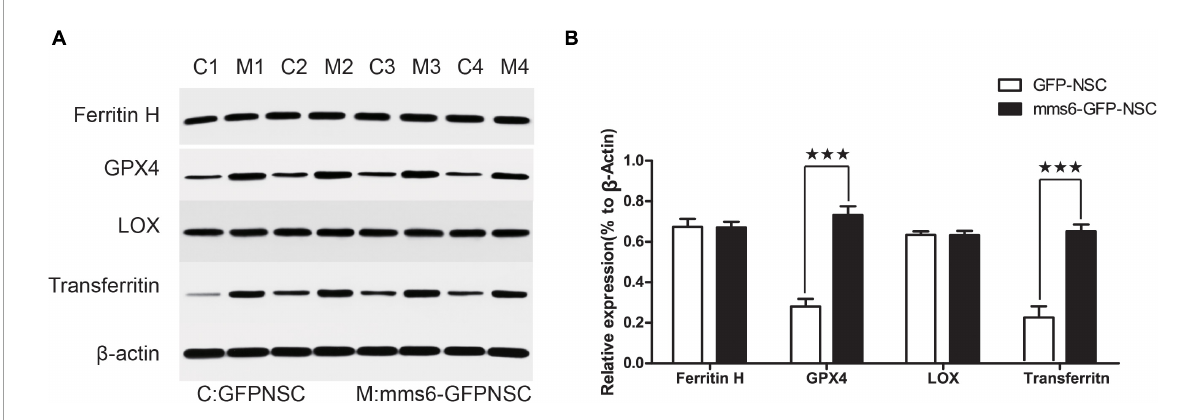
FIGURE4 The expression of mms6 increased the glutathione peroxidase 4 (GPX4) level of NSCs. (A) Western blotting (WB) of mms6-GFP-NSCs and GFP-NSCs; (B) the results of WB showed that the expression of GPX4, but not that of LOX, was significantly increased by the expression of mms6 . MN, mms6-GFP-NSCs; GN, GFP-NSCs. *** indicates a P -value <